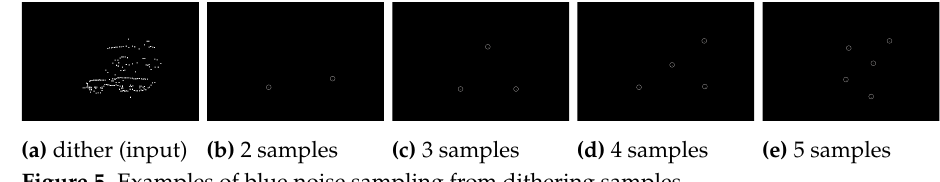
Figure 5. Examples of blue noise sampling from dithering